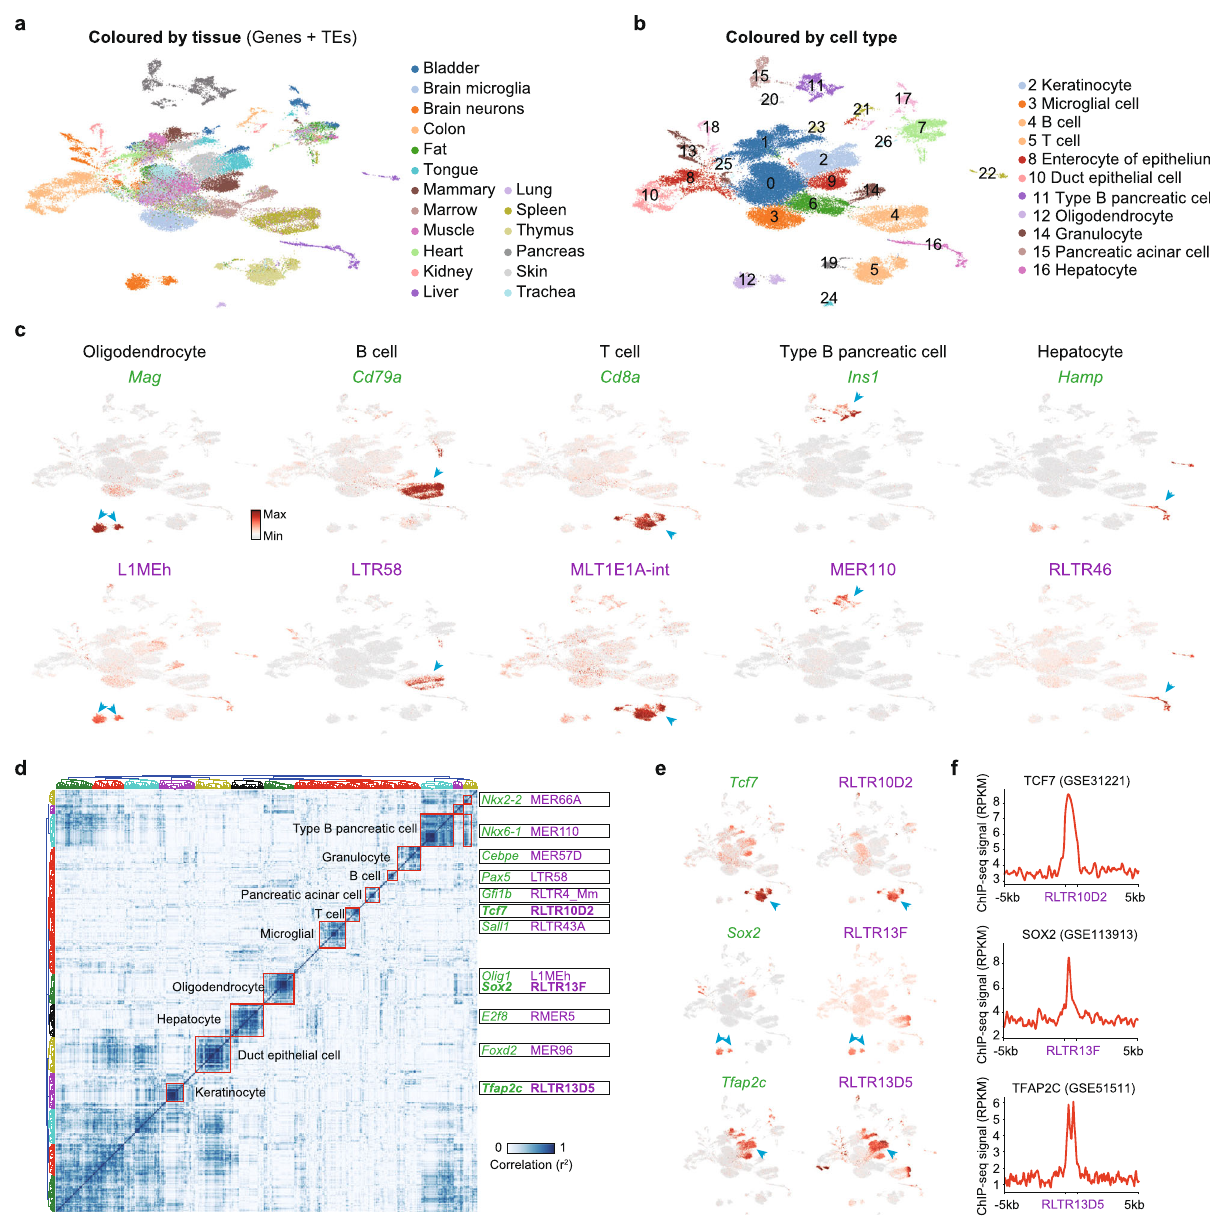
Fig. 4 Class-speci fi c expression of TEs in somatic cells. a UMAP plots of the Tabula Muris data, using both genes and TEs as analyzed with scTE. The tissue sources for the cells are indicated. b UMAP plot as in ( a ), but clustered into groups (Leiden, resolution = 0.5). c Same as ( b ), but cells are colored by the expression of indicated genes/TEs. d Correlation heatmap showing the co-expression of TFs and TEs. e UMAP plots showing the expression of indicated TFs and TEs. f Read count tag density pileups for TCF7, SOX2, and TFAP2C ChIP-seq data on the indicated